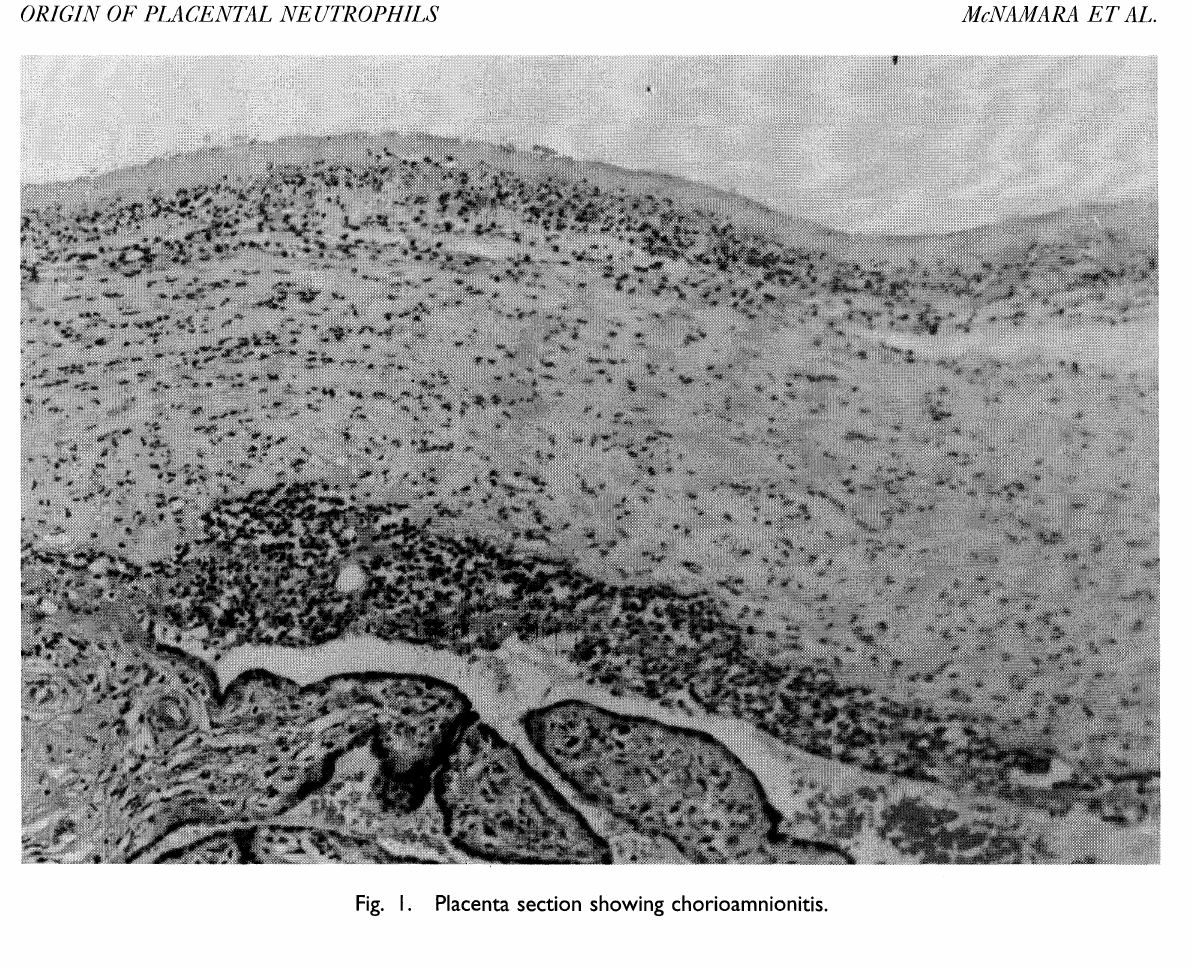
Fig. I. Placenta section showing